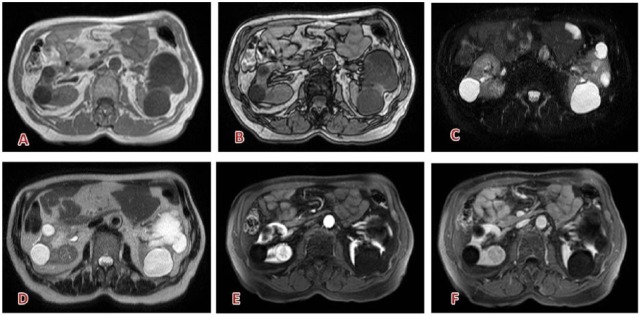
Typical clear-cell carcinoma of the right kidney: well-defined capsulated solid lesion, (A) hypointense on T1-weighted, with subtle signal loss in the out-of-phase sequence (intracellular fat, B); (C) partially restricted diffusion, inhomogeneous; (D) slightly hyperintense on T2; (E) strong and rapid enhancement in corticomedullary phase; (F) best seen on nephrogenic phase. Contrast agent: gadobutrol, 6.5 mL. Courtesy of Professor De Cobelli, Radiology Department, San Raffaele Scientific Institute, Milan.